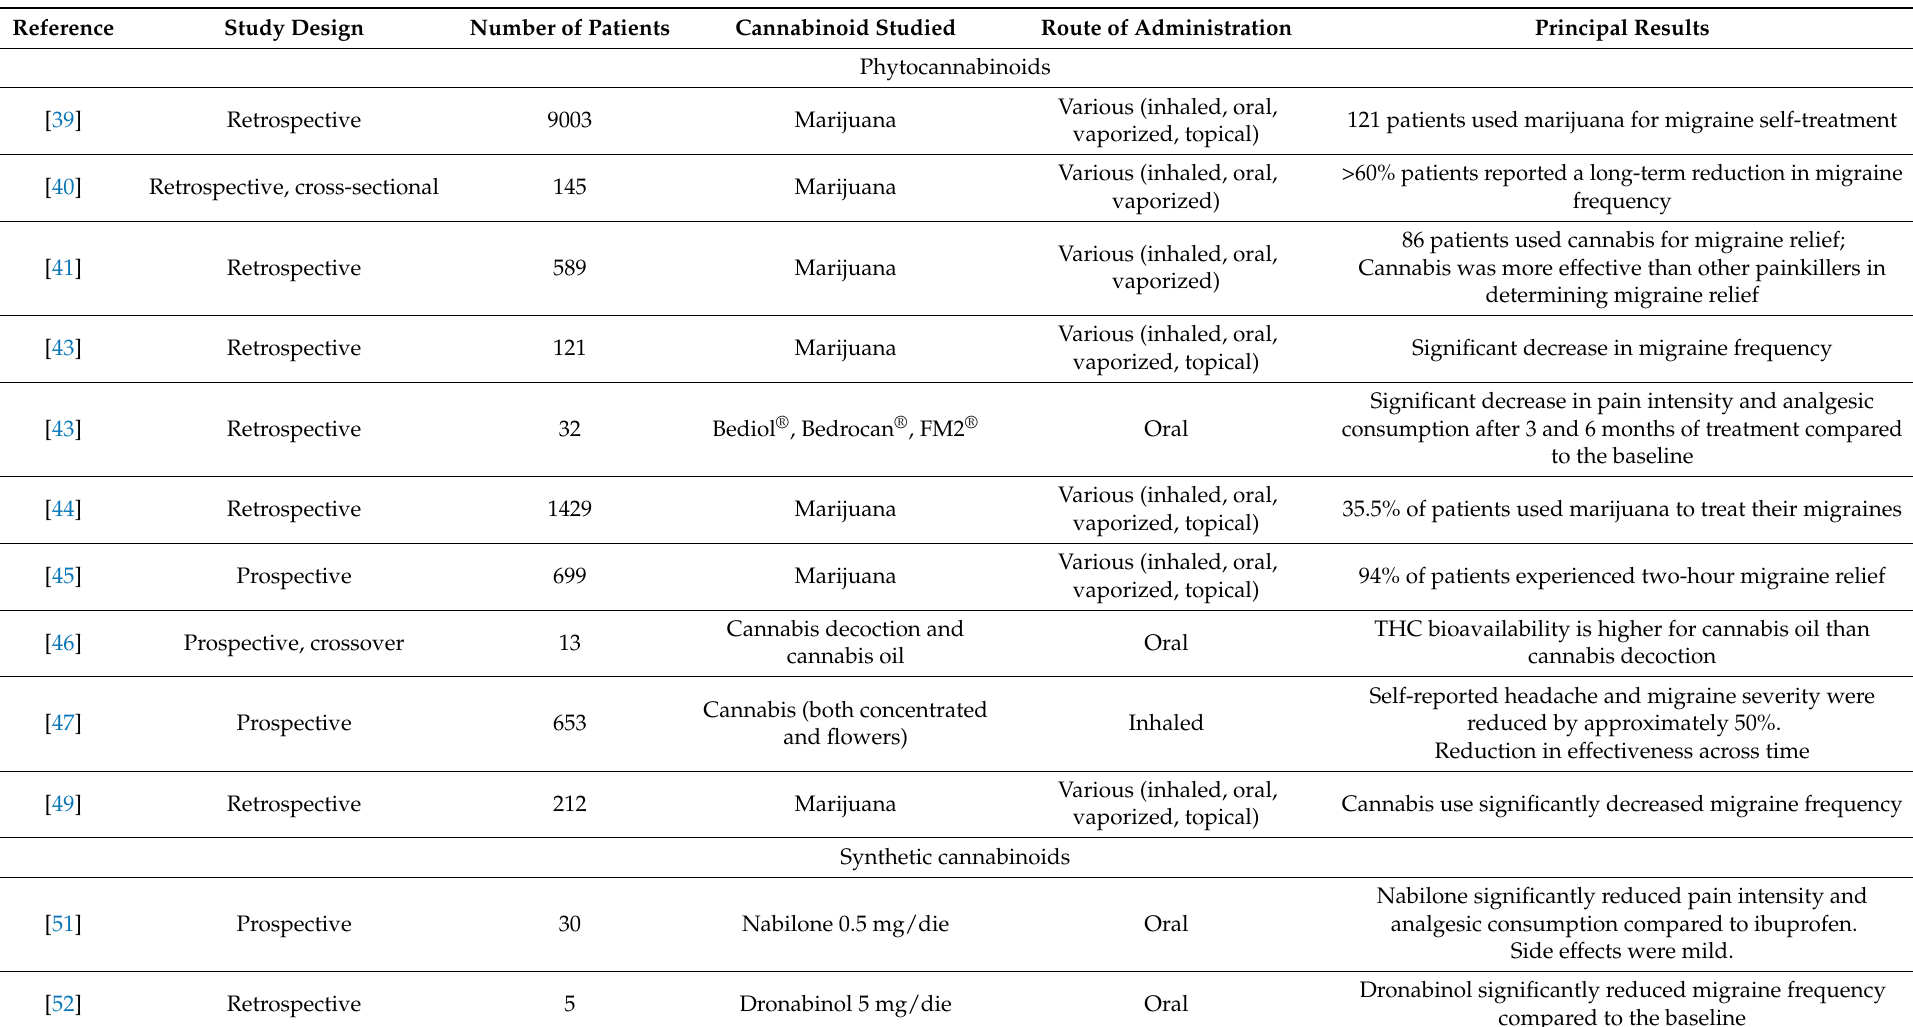
Table 1. Clinical studies on phytocannabinoid and synthetic cannabinoid use in